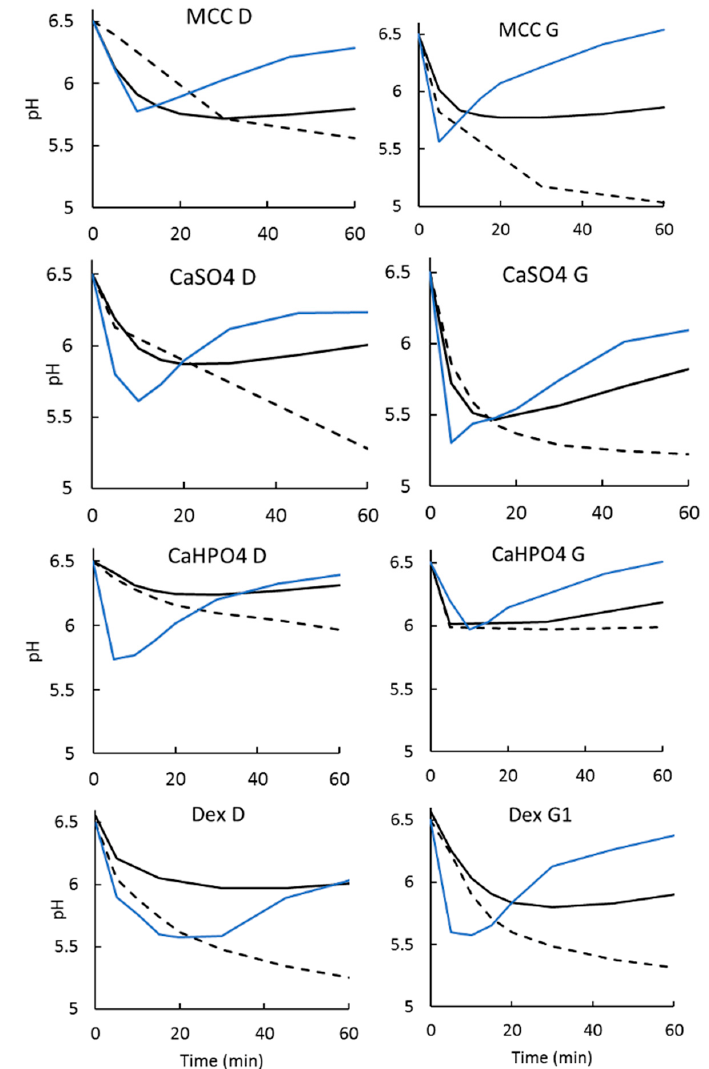
Figure 6. pH measurements for dissolution tests in a low buffer capacity medium. Dashed line: monophasic setup. Solid black line: biphasic setup with an aqueous layer at 900 mL. Solid blue line: biphasic setup with an aqueous layer at 200 mL.